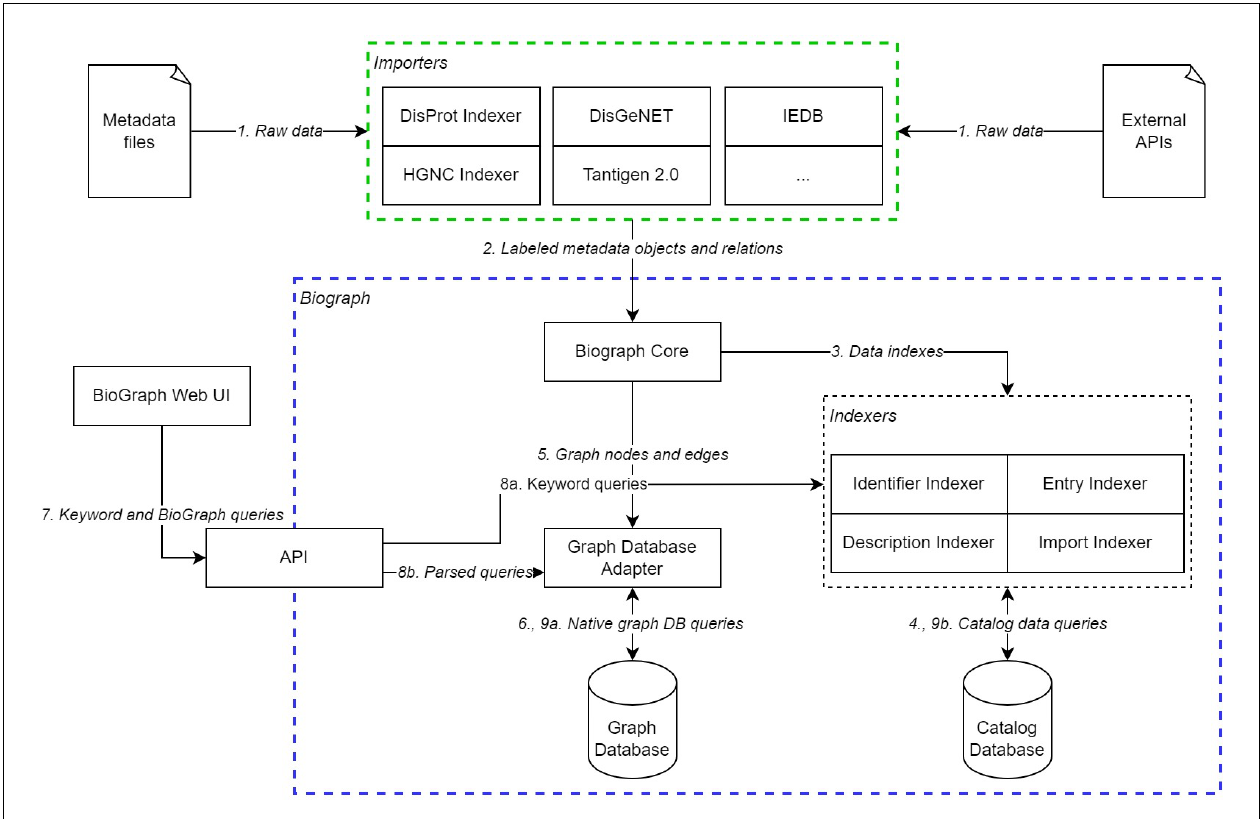
Figure 4. Diagram representing the architecture of the system which implements the BioGraph data model. The raw data are collected from external data sources (step 1) and a subset of collected data is labeled and transformed into BioGraph model elements using importers specialized for the selected external data source. The list of importers shown in the figure is not final; it represents the current state of the system and can be easily extended for different data sources. Labeled metadata